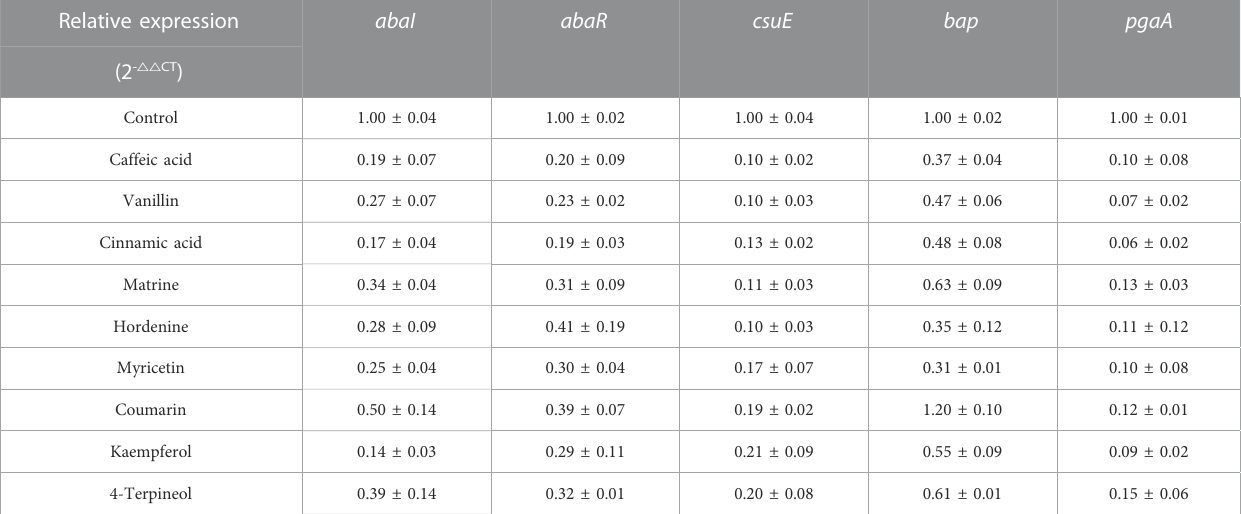
TABLE 6 Effect of 9 TCMMs on the virulence factor-related gene expression of XDRAB at 1/8 MIC (x ± s, n = 3). Relative